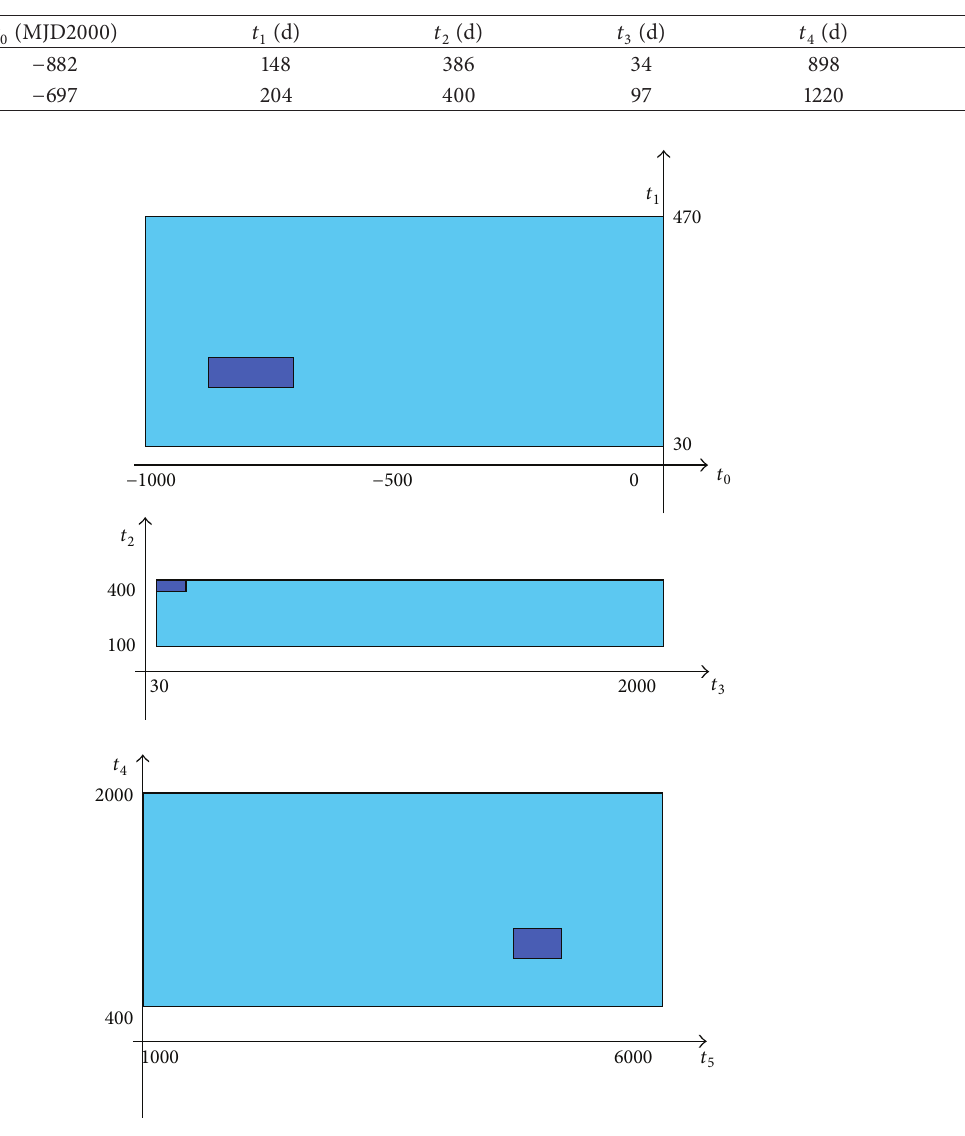
Figure 3: Community range in